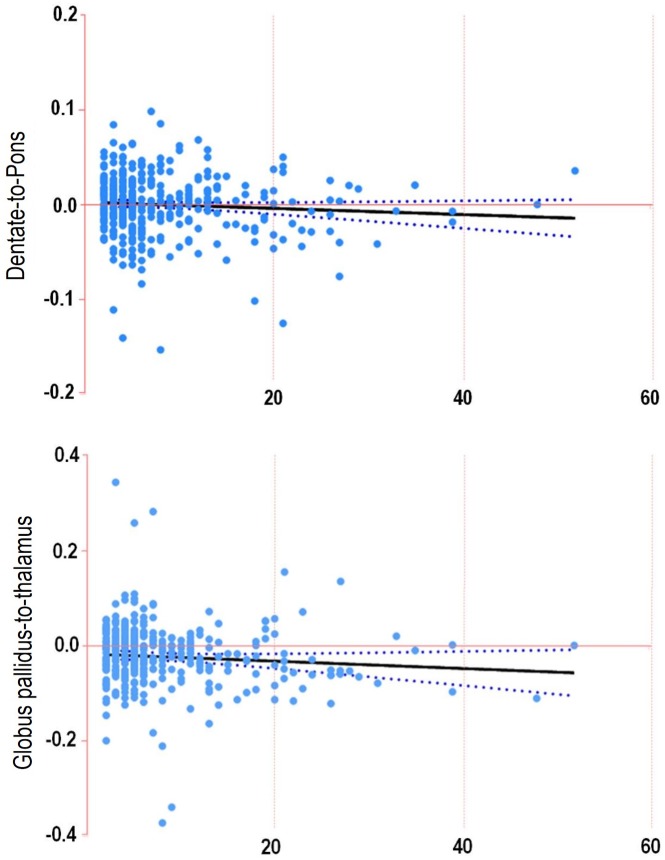
(A) Scatterplot of the mean dentate nucleus-to-pons signal intensity ratio difference with the number of macrocyclic ionic MR contrast agent (MICA) administrations. (B) Scatterplot of mean globus pallidus-to-thalamus signal intensity ratio difference with the number of MICA administrations. In each plot, the solid line represents linear regression and the dashed lines indicate 95% confidence intervals.